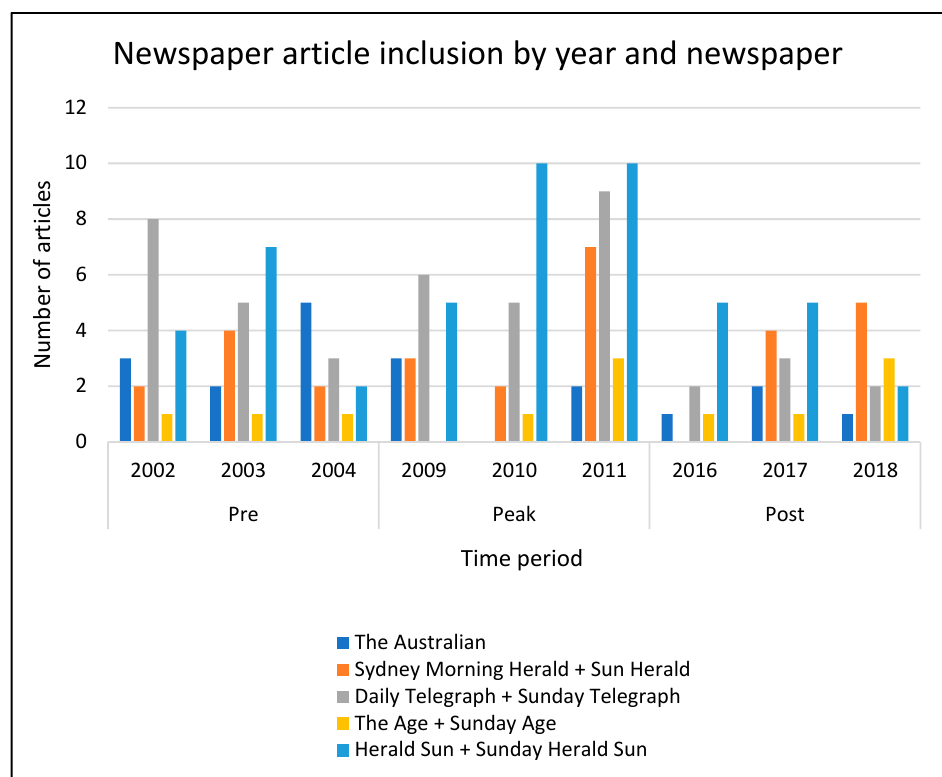
Figure 3. Newspaper articles included in media analysis by year and newspaper.